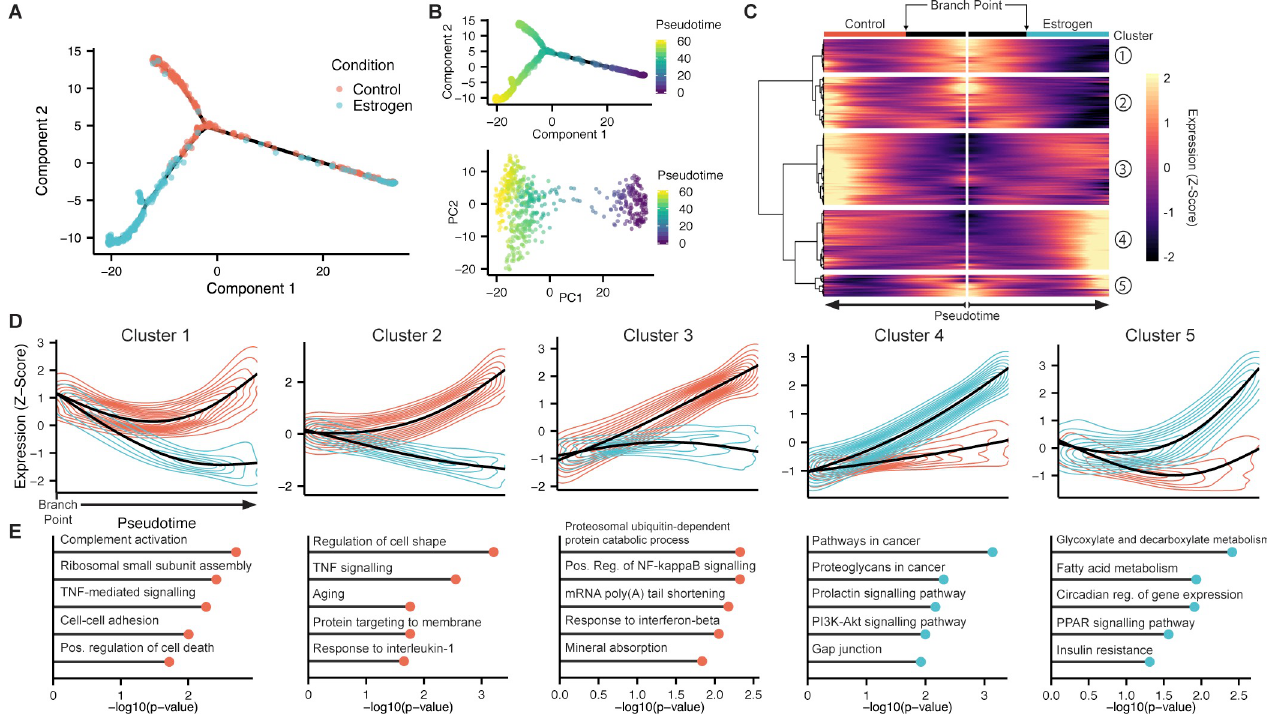
Fig 5. Trajectory analysis reveals phenotypic divergence of E2-treated cells. (A) Pseudotemporal trajectory of control and E2-treated OSE cells constructed by Monocle2. Data points are coloured by treatment. (B) The same trajectory (top) and PCA (bottom) coloured by the cells’ assigned pseudotime value. (C) Clustered heatmap of genes with branch-dependent gene expression as a function of pseudotime. The center of the heatmap represents the root cell (pseudotime = 0). Cells are ordered by increasing pseudotime value, diverging outwards from the heatmap’s center, corresponding to the two condition- specific trajectories. (D) Expression dynamics of genes from each cluster. The black line represents the average scaled (Z-score) expression values, which is surrounded by the two-dimensional kernel density estimate. Values are separated by branch (control-dominated branch: red; estrogen: blue). (E) Top KEGG Pathways and GO Terms (p-value < 0.05) associated with the genes of each